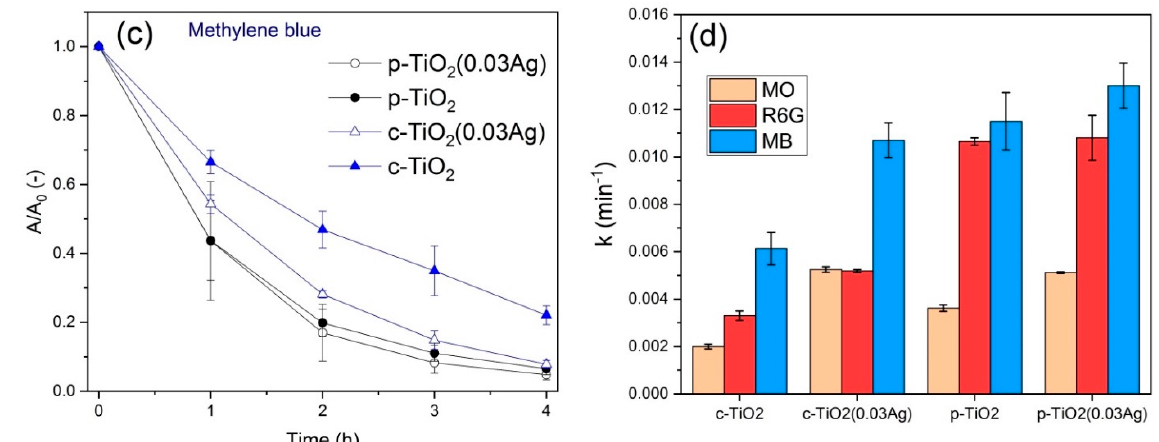
Figure 8. A/A 0 − t curves of ( a ) methyl orange, ( b ) Rhodamine 6G and ( c ) methylene blue dye photodegradation at the liquid–solid interface, in the case of different TiO 2 samples; ( d ) kinetics of dye degradation: first order k values.